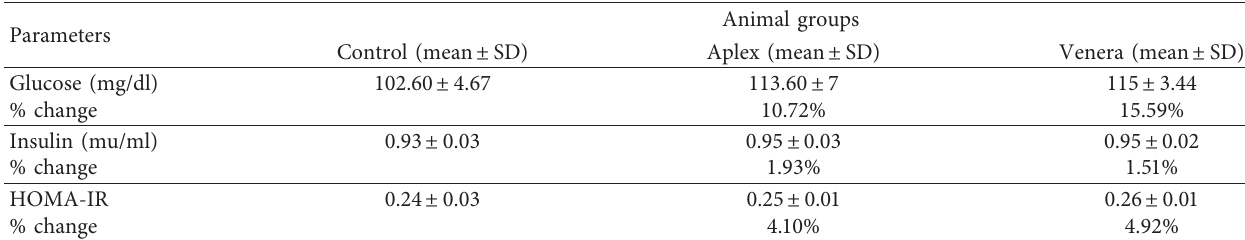
Table 2: Pancreatic function biomarkers in sera of control and treated animal groups.